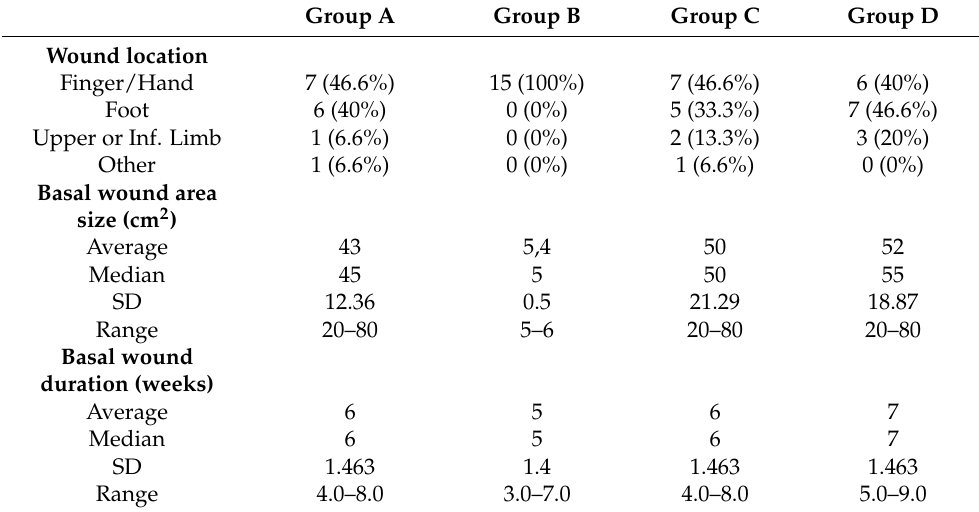
Table 3. Characteristics of basal wound